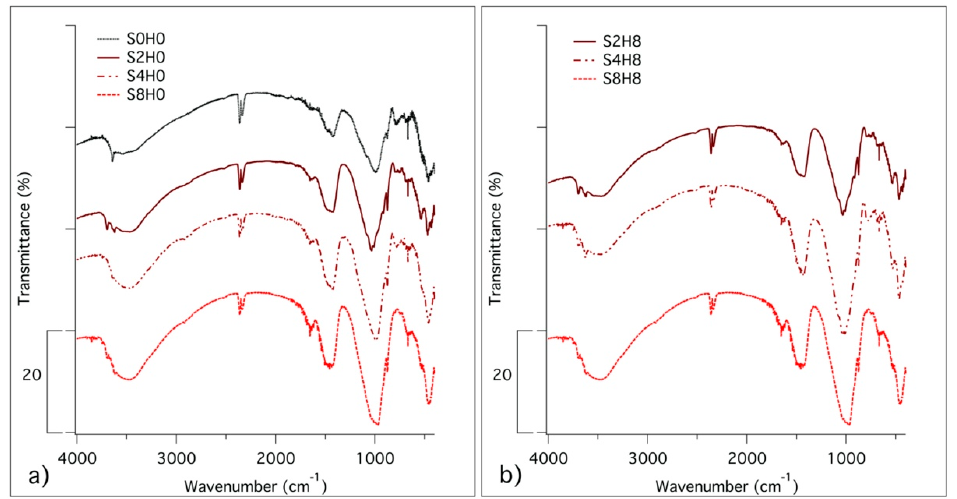
Figure 4. FTIR spectra of ( a ) S0H0, S2H0, S4H0 and S8H0; ( b ) S2H8, S4H8, S8H8. Samples have been lyophilized and analysed after 28 days of hydration. Spectra have been o ff set for the sake of